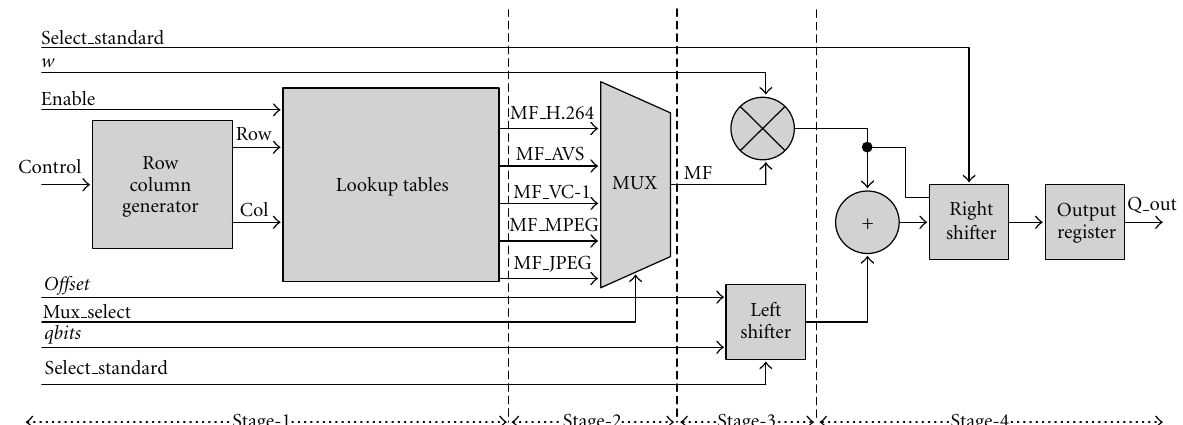
Figure 5: Detailed block diagram of the entire operation with all the pipelining boundaries.